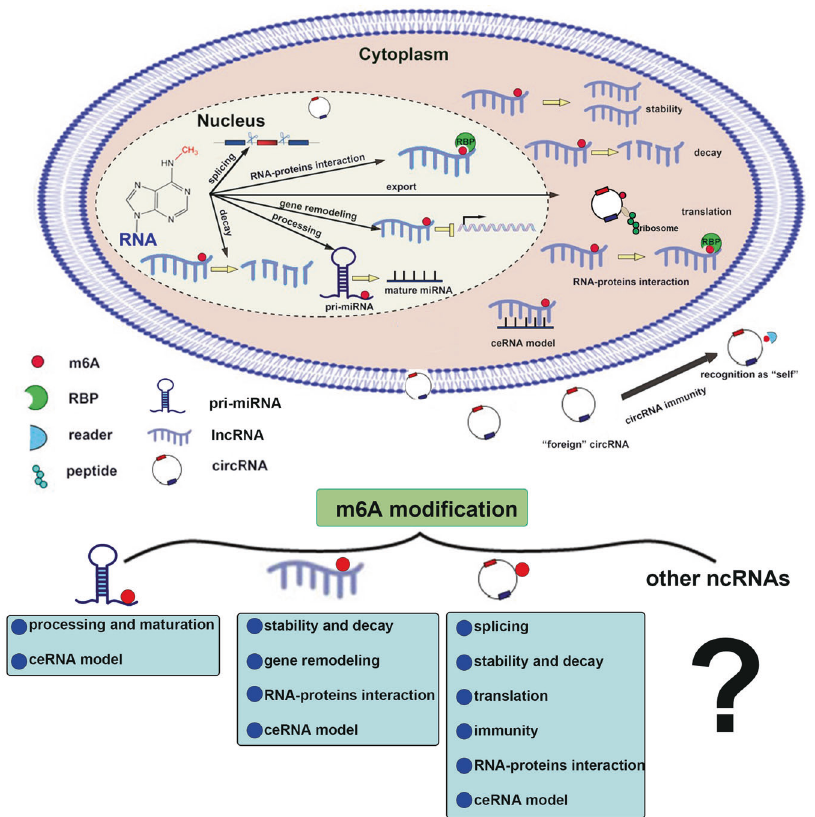
Fig. 3 The molecular mechanism involved in m6A modi fi cation of ncRNAs. Top: In the nucleus, m6A modi fi cation can regulate splicing, processing, stability, interacting with RNA-binding proteins (RBP), and nucleus export of ncRNAs. The m6A-modi fi ed lncRNA mediates gene remodeling. In the cytoplasm, m6A modi fi cation mediates ncRNA translation, stability, ceRNA function, and interacting with RBP. Extracellular m6A modi fi cation can regulate circRNA immunity. Bottom: The m6A modi fi cation could regulate the processing, maturation, and ceRNA function of miRNAs. The m6A modi fi cation could regulate the stability, RBP interaction, and ceRNA function of lncRNAs, and m6A-modi fi ed lncRNA could regulate gene remodeling. The m6A modi fi cation could regulate the splicing, stability, translation, immunity, RBP interaction, and ceRNA function of